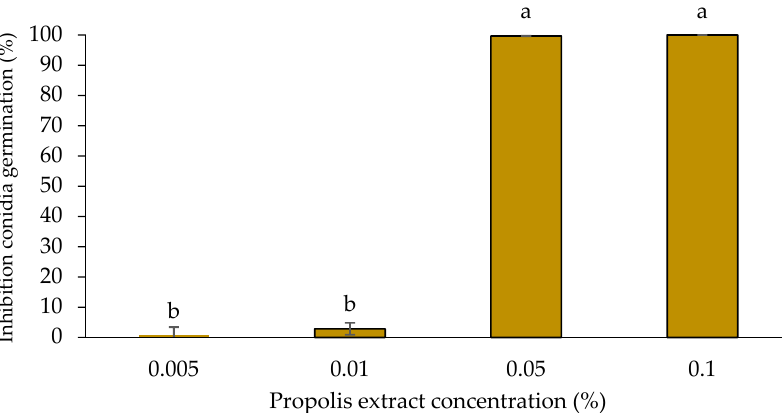
Figure 7. Effect of propolis extracts (LR16) at different concentrations on the germination of Phlyctema vagabunda (CP13 isolate) conidia. Lowercase letters indicate statistical differences between propolis concentrations after Tukey test ( p < 0.05).